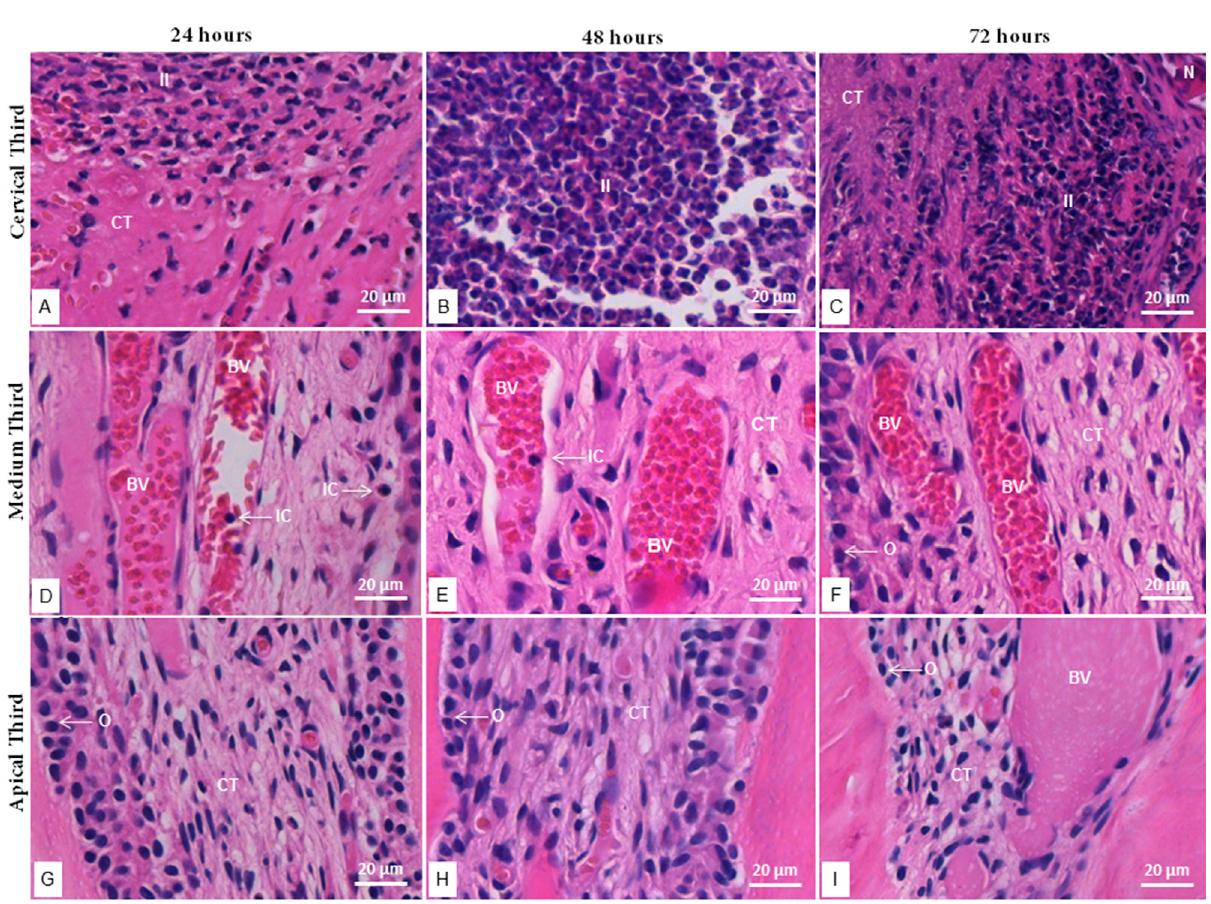
Figure 2- Photomicrographs of hematoxylin and eosin-stained cervical radicular third of SF-treated teeth. A: At 24 hours, presence of superficial tissue (ST) in contact with the material, followed by an inflammatory infiltrate (II), necrosis (N) and an acellular layer (AC); B: At 48 hours, presence of II and disorganized connective tissue (CT); C: At 72 hours, presence of ST in contact with the material, followed by an AC and several congested blood vessels (BV), and dispersing II through the pulp tissue. 20x magnification